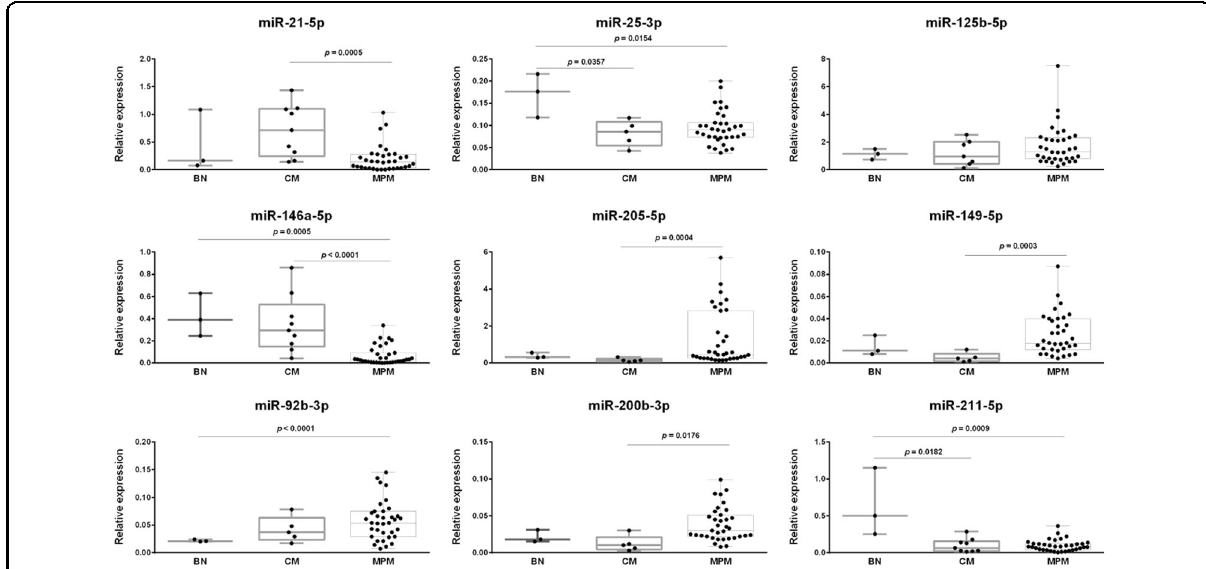
Fig. 2 Differential microRNA expression in benign nevi (BN), cutaneous melanoma (CM), and in multiple primary melanoma (MPM). Box and whiskers graph representation of nine microRNAs differentially expressed in single and multiple primary melanomas ( P < 0.05). MPM shows higher expression levels of miR-205-5p, miR-200b-3p, and miR-149-5p compared to CM, and higher expression of miR-92b-3p compared to BN. MPM downregulates miR-21-5p compared to CM and miR-146a-5p compared to CM and BN. BN upregulates miR-25-3p and miR-211-5p compared to CM and MPM. Each miRNA was tested in triplicate by quantitative RT-PCR. Relative miRNA expression was normalized on invariant miR-16-5p. The bar shows minimum and maximum values; superimposed points represent all individual